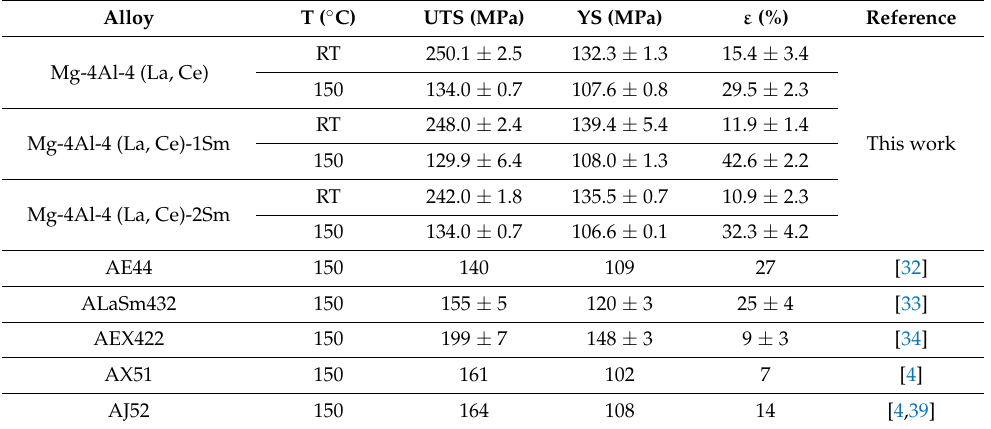
Figure 9. Mechanical properties of different alloys. Table 2. Mechanical properties of Mg-4Al-4 (La, Ce)- x Sm alloy and traditional Mg-Al-based alloy.